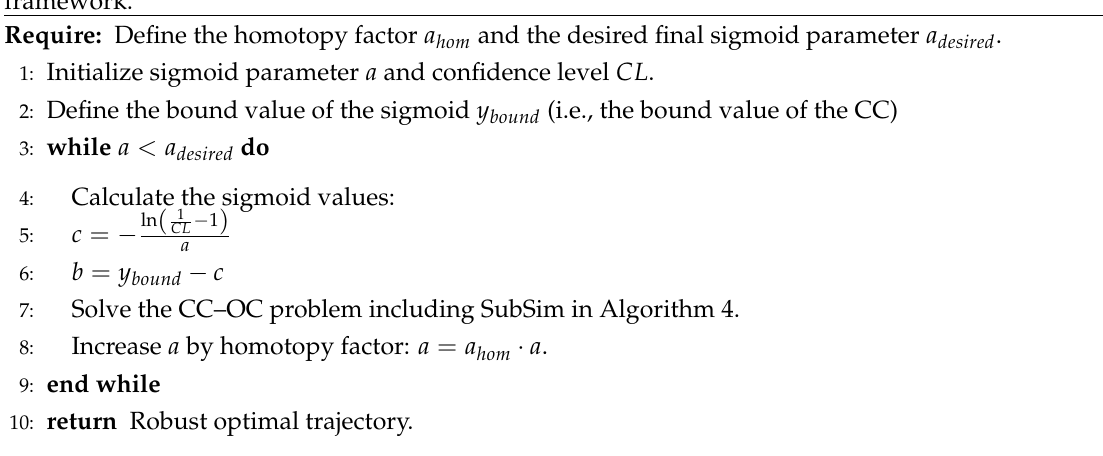
Algorithm 1 Implemented homotopy strategy for sigmoid scaling and offset parameter in CC–OC